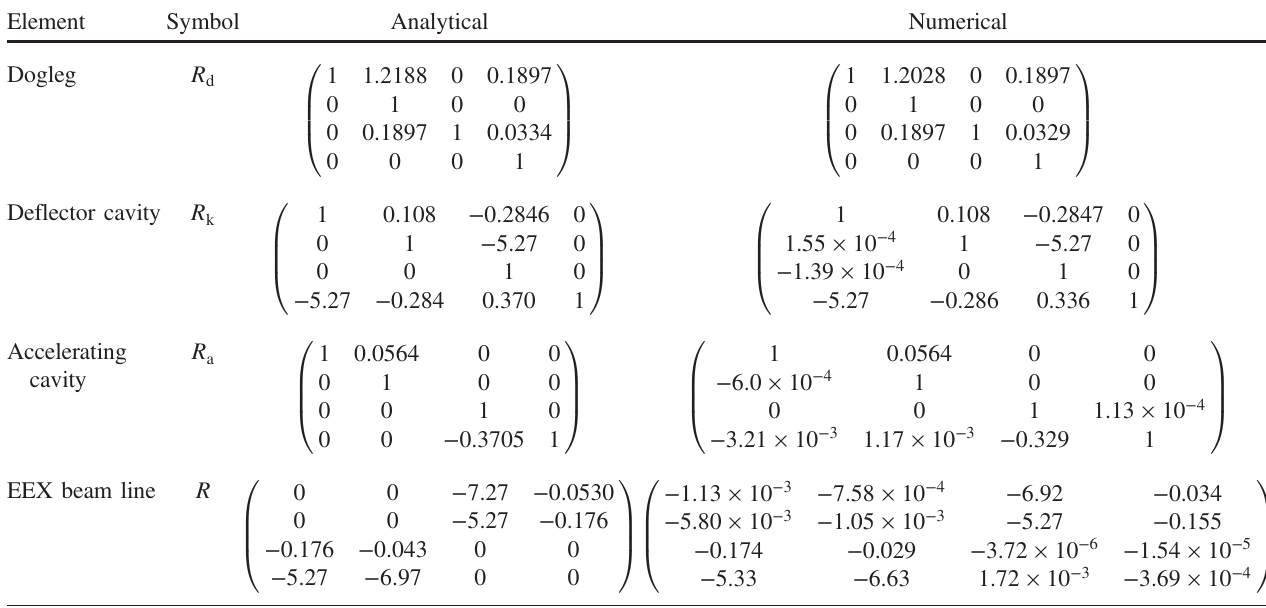
TABLE III. First order transfer matrix. Element Symbol Analytical Numerical